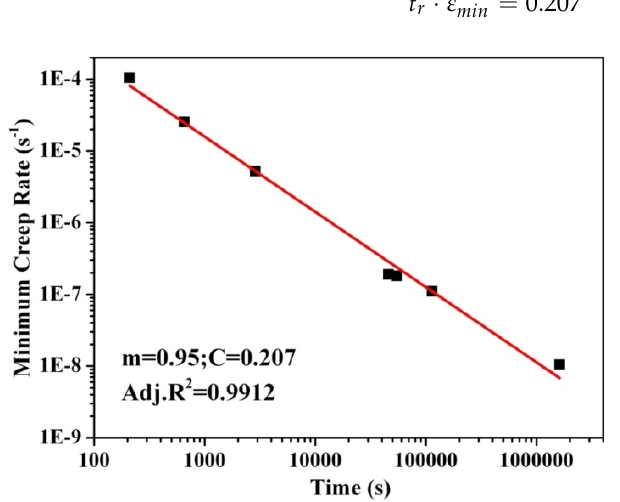
Figure 13. Monkman–Grant fitting of creep life of Al-Si-Cu-Ni-Mg alloy. Table 3. Correspondence table of creep life and minimum creep rate.